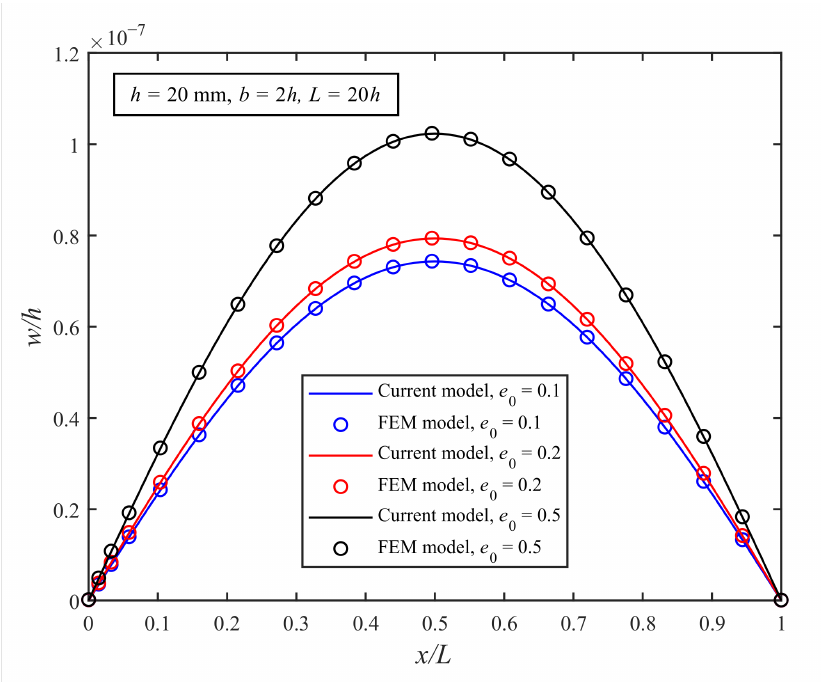
Figure 2. Comparison of the deflections of the simply supported microbeam model applied to a uniform load.